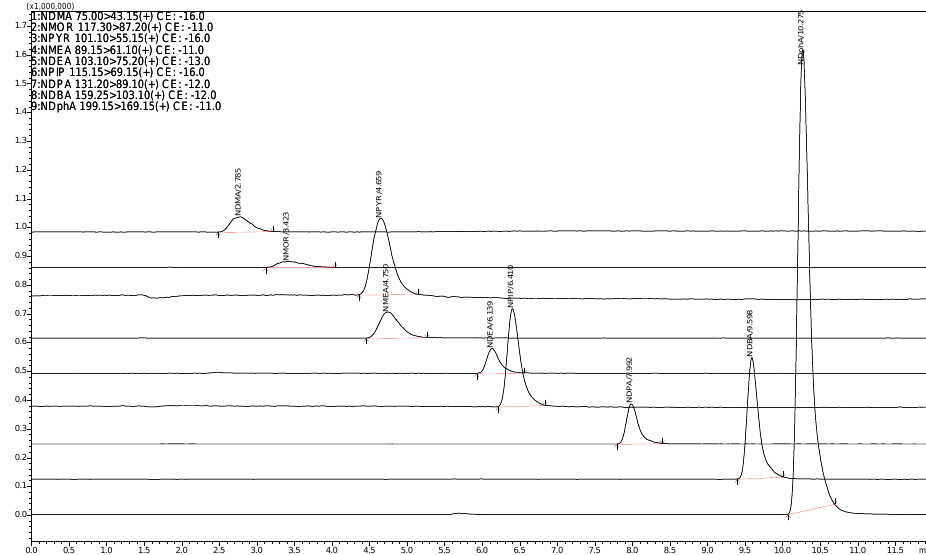
Figure 1. MRM chromatogram of N-nitrosamine compounds (50.0 µ g · L − 1